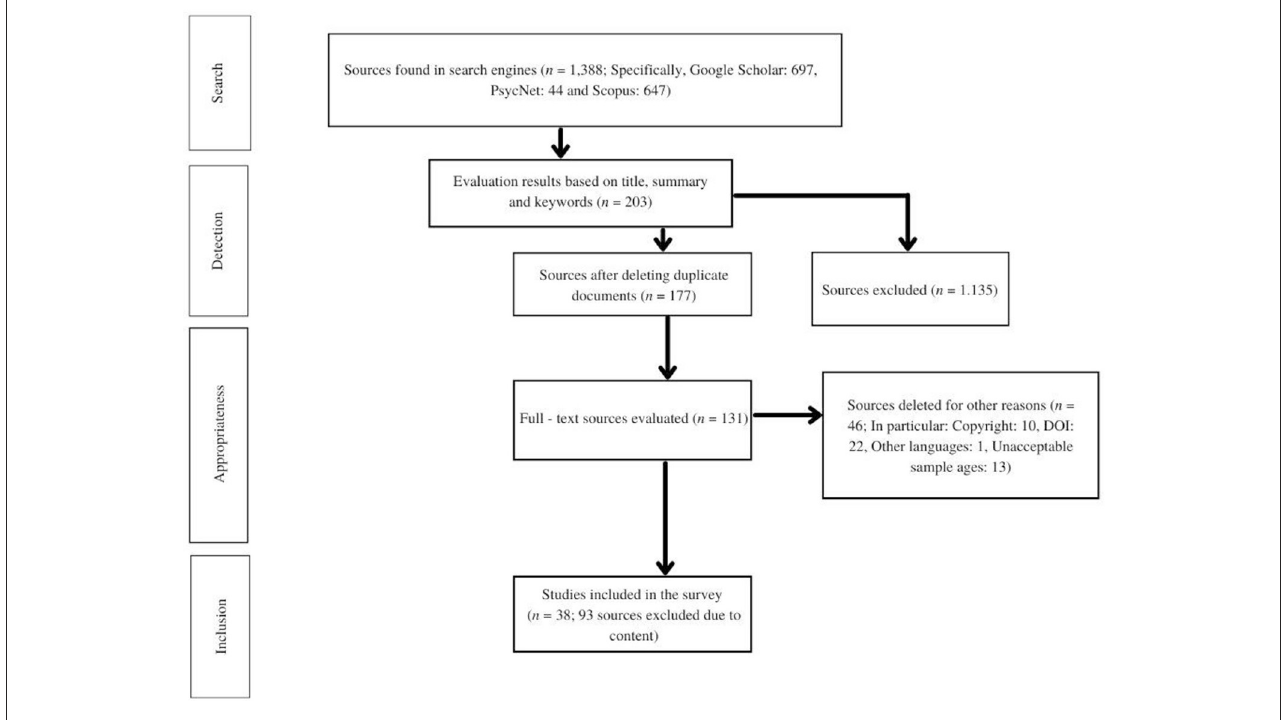
FIGURE1 Flow diagram of search strategy and source